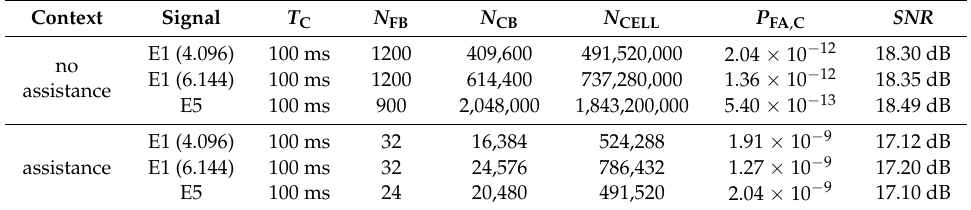
Table 15. Search space and statistical parameters for P FA,G = 10 − 3 and P D = 0.9 for different contexts with Galileo signals. The same values are considered for unlimited T C .